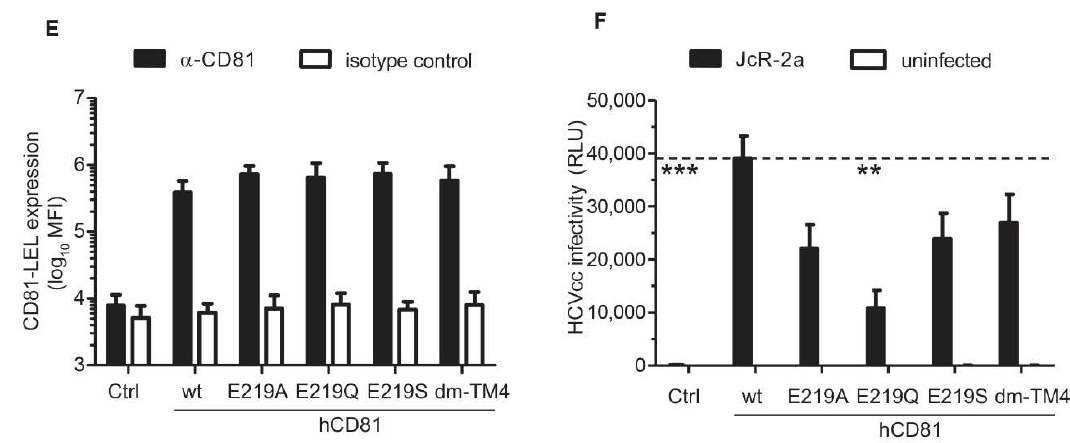
Figure 8. Transmembrane domain four of dmTSP90F and cdTSP9 critically differ from hCD81. ( A , B ) Scheme of the structural domains of hCD81 and amino acid sequence divergence scan of hCD81 chimeras with HCV entry supporting ( A ) or resistant ( B ) backbones; ( C ) Amino acid sequence alignment of the transmembrane domain four (TM4) and the N-terminus of the tetraspanin chimeras used in this study. The cholesterol binding residue E219 is highlighted in light blue. A conserved palmitoylation site and an internalization motif are highlighted in black; ( D ) Structure of full length hCD81 with bound cholesterol (light red, ball and stick) and the E219 residue (blue, ball and stick). The boundaries of the plasma membrane are indicated by horizontal lines. (PDB: 5TCX) [19]. CD81 amino acids are colored according to the side chain hydrophobicity (polar: blue, nonpolar: red). Disulfide bonds in LEL highlighted in orange. The insert shows the zoom into the E219–cholesterol interface formed by hydrogen bonds between the E219 carboxyl group and the cholesterol hydroxyl group (oxygen atoms labelled in red, nitrogen in blue). ( E ) Cell surface staining of hCD81 on TM4 mutant transduced Lunet N#3 cells as described in Figure 1D. ( F ) Infectivity of luciferase reporter HCV strain (Jc-R2A) in hCD81 TM4 mutant expressing Lunet N#3 cells as described in Figure 6A. Data shown as mean + SEM of four independent biological replicates each performed in technical triplicates. ** p ≤ 0.01, *** p ≤ 0.001.